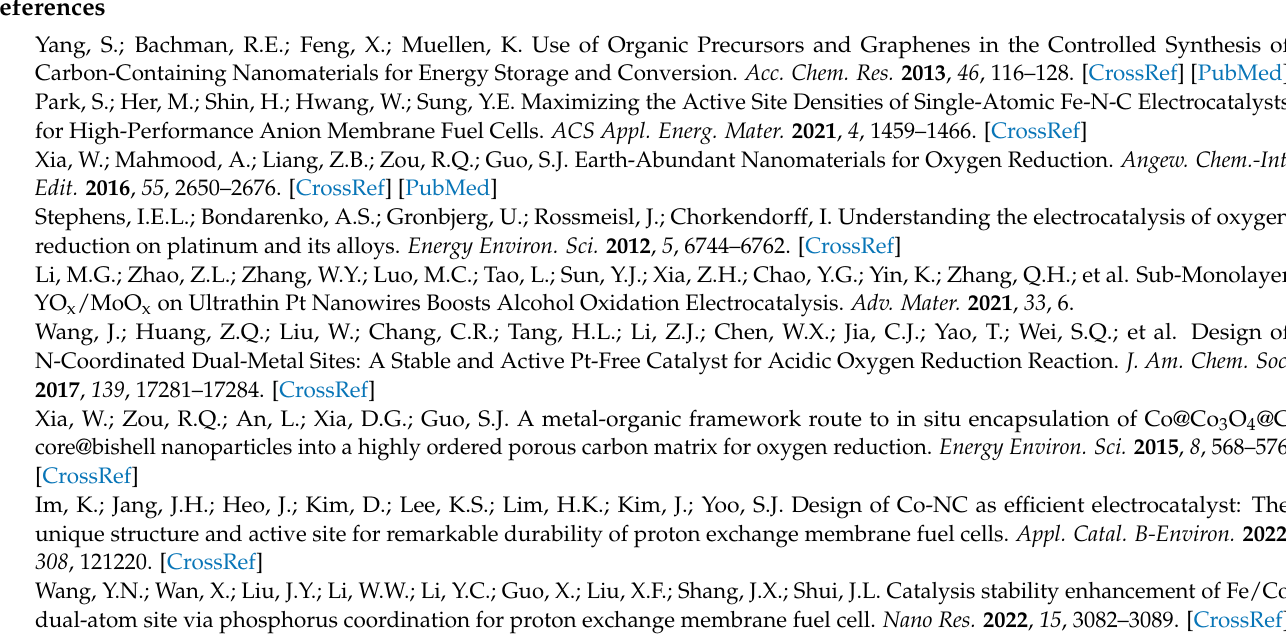
Figure S8: (a) Raman spectra of MIL-N-CNFs-x-800 catalysts. (b) Raman spectra of MIL-N-CNFs-2-T catalysts; Figure S9: XPS survey spectrum of (a)MIL-N-CNFs-x-800 catalysts(x referred to the mass ratio of Fe-MIL to PAN) (b) MIL-N-CNFs-2-T catalysts pyrolyzed under different temperatures; Figure S10: LSV curves at 10 mV/s and a rotating speed of 1600 rpm in 0.1M KOH of MIL-N-CNFs- 2-T catalysts; Table S1: Comparison of the ORR performance of the recently published non-noble metal catalysts (0.1 M KOH at 1600 rpm); Table S2: Features of all samples; Table S3: The nitrogen contents and states of MIL-N-CNFs-x-T catalysts; Table S4: Fe content of MIL-N-CNFs-x-T catalysts; Table S5: Onset potential and half-wave potential of MIL-N-CNFs-x-T catalysts, N-CNFs, MIL-800, MIL-NC-1.5-800 and 20% Pt/C; Table S6: Comparison of AEMFC performances using different NPMC cathode catalysts. References [37–62] are cited in the Supplementary